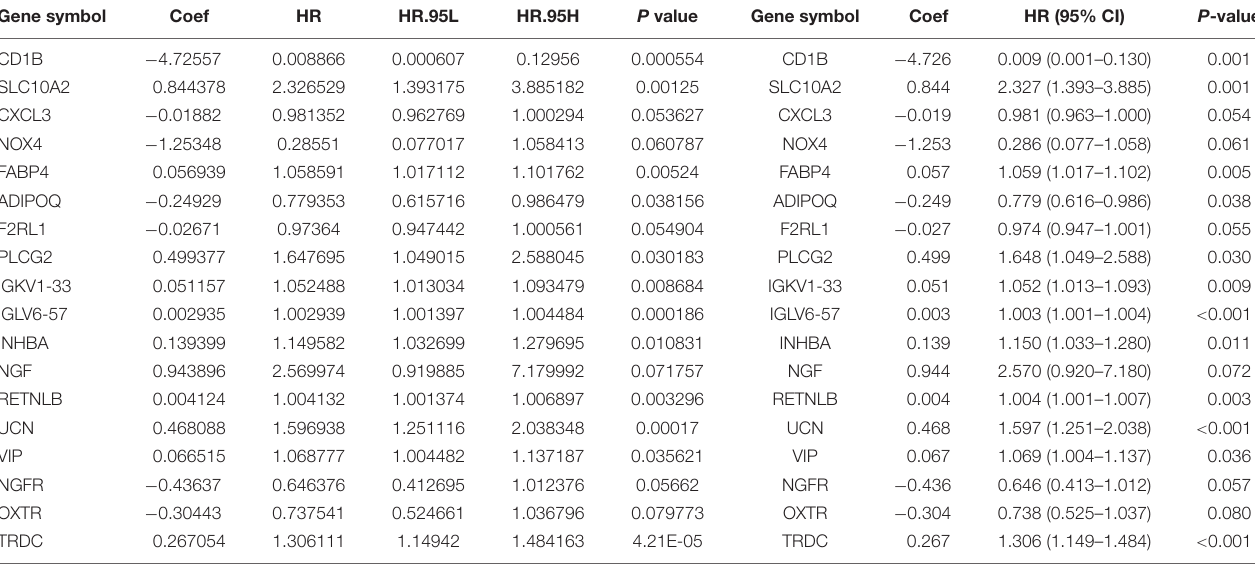
TABLE 3 | Eighteen genes that constitute the immune-related prognostic model and the corresponding risk factors Riskscore = CD1B*(-4.726) + SLC10A2*(0.844) + CXCL3*(-0.019) + NOX4*(-1.253) + FABP4*(0.057) + ADIPOQ*(-0.249) + F2RL1*(-0.027) + PLCG2*(0.499) + IGKV1